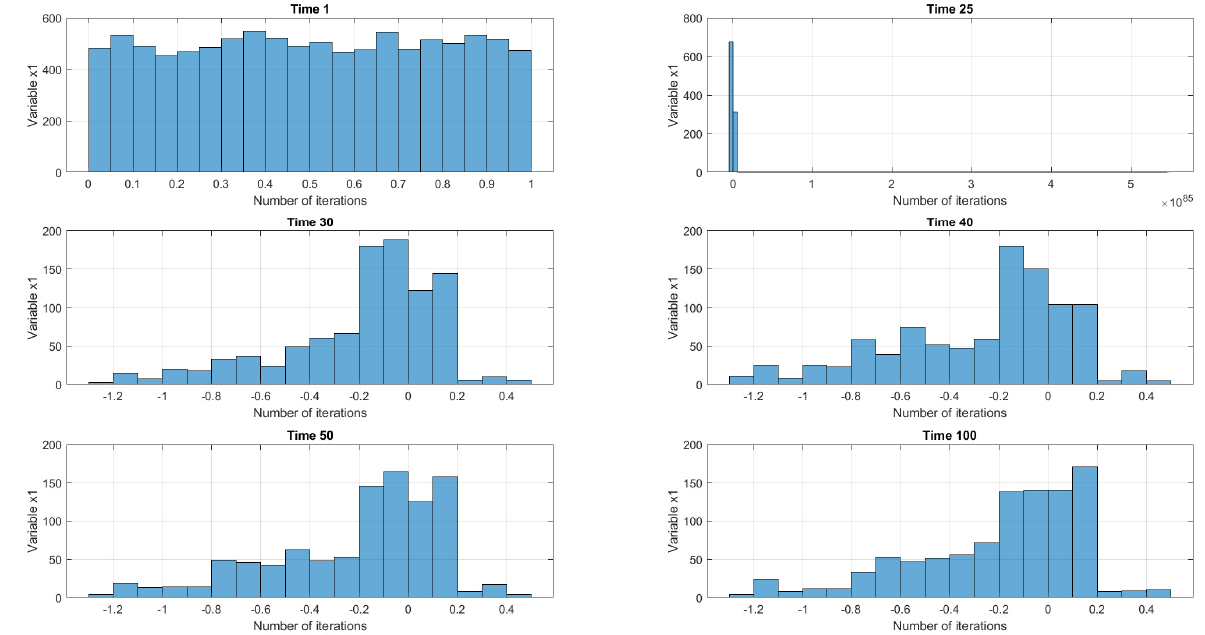
Figure 8. Transient time—Tinkerbell map—histograms for variable x 1 .